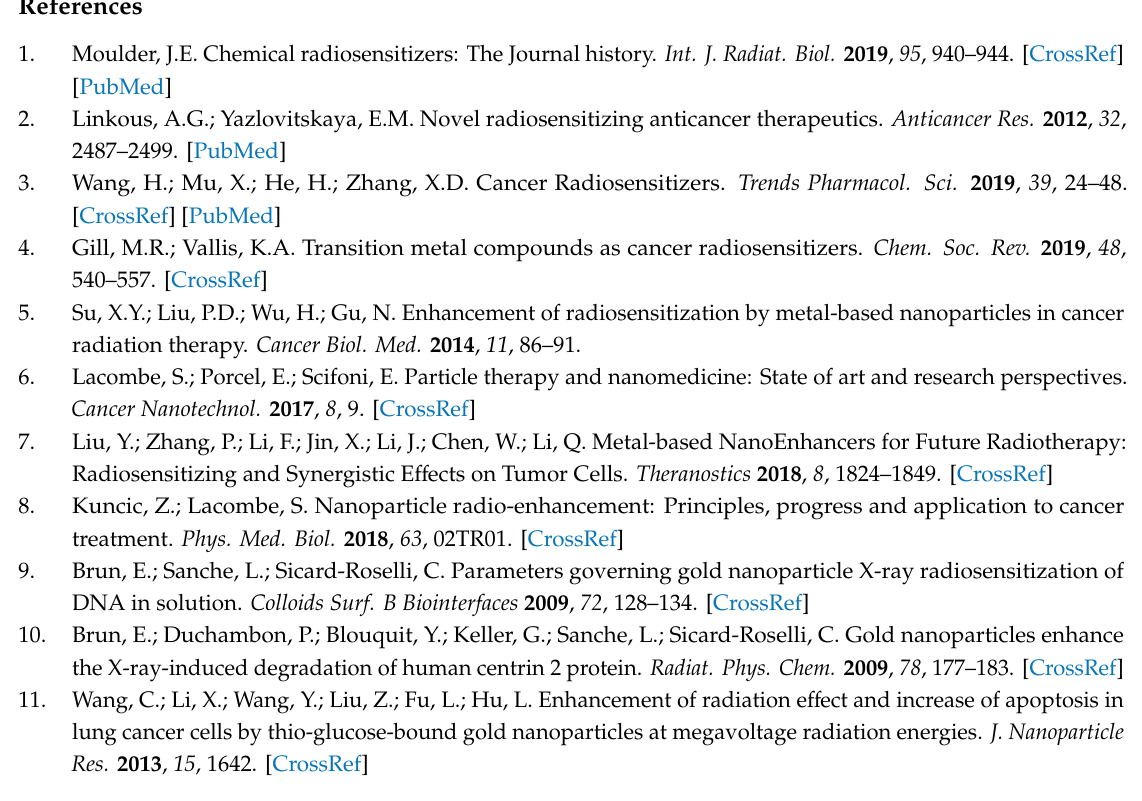
Figure S1: Normalized spectra calculated using Geant4 for a given set of X-ray tubes. Table S1: Characteristics of X-ray tubes used in the Monte-Carlo